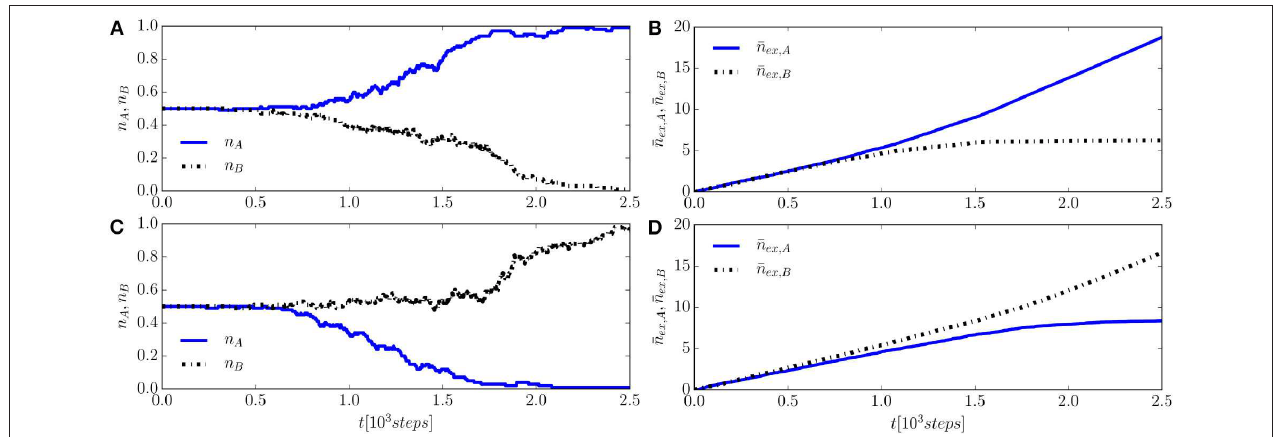
FIGURE 8 | Results from two single simulations of a system with N about name A or B . (A,C) Show the population fractions x ( t ) n ex , A ( t ) and n ex , B ( t agent, ¯ ¯